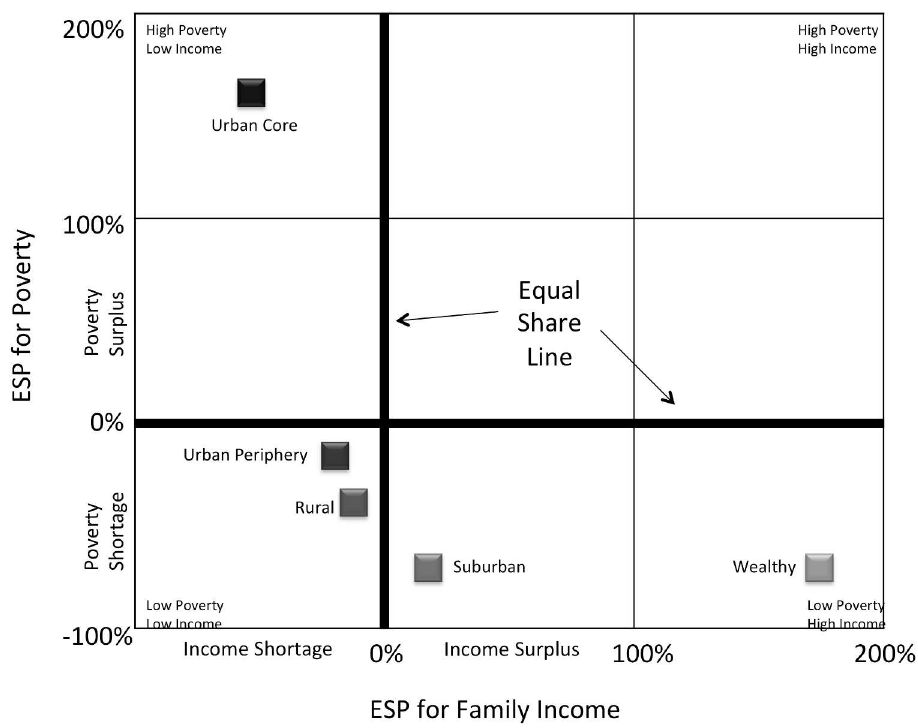
Fig 1. The 5 Connecticut socioeconomic status (SES) categories demonstrating the equal share percentage (ESP) for family income and poverty as of 2000. Town of residence (by participant’s zip code) was classifiedaccordingto the 5 Connecticuts study as urban core, urban periphery,suburban, wealthy, or rural as proxiesfor area of residence. These proxieswere determined by combiningtown-levelpopulation density, medianfamily income, and percent of residents living in poverty (definedas the percentageof population below the 100%poverty threshold) The equal share line (whereESP = 0%) marks where the share of a variable does not differ from the statewide average. Adapted with permissionfrom The Five Connecticuts report Figure 7 .